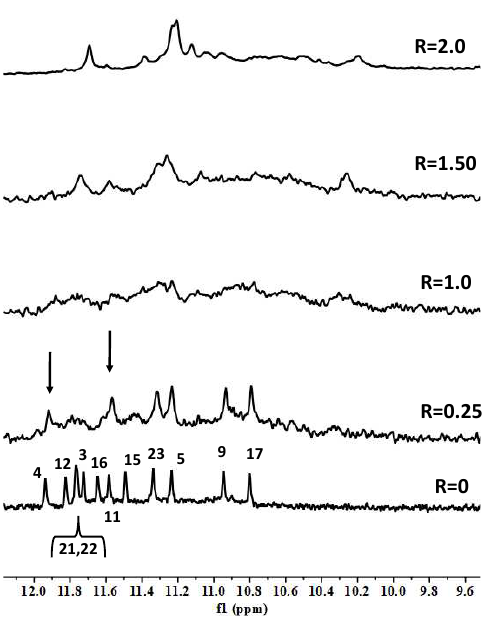
Figure 10. Imino proton region of 1D NMR titration spectra of TP3-T6 with RHPS4 at 25 ◦ C at Figure 10 . Imino proton region of 1D NMR titration spectra of TP3- T6 with RHPS4 at 25 °C at dif- different R = (drug)/(DNA) ferent R = (drug)/(DNA) ratios.